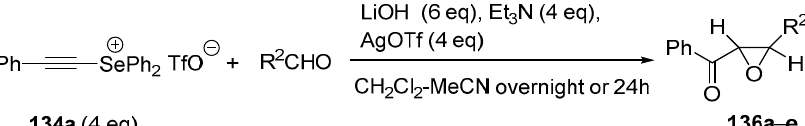
Table 10. Reaction time and yields of oxiranylketones 136a – e obtained from ketoselenonium ylide 134a and aliphatic aldehydes.